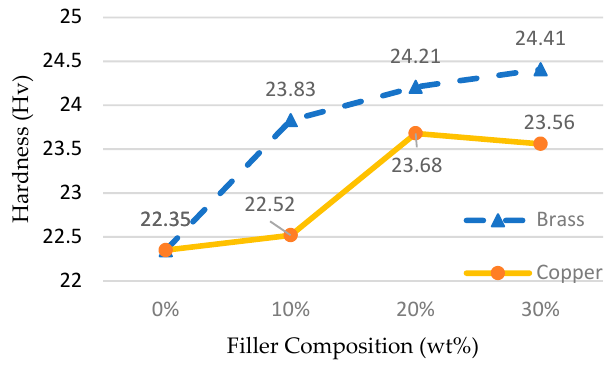
Figure 9. Effects of fillers on the hardness.